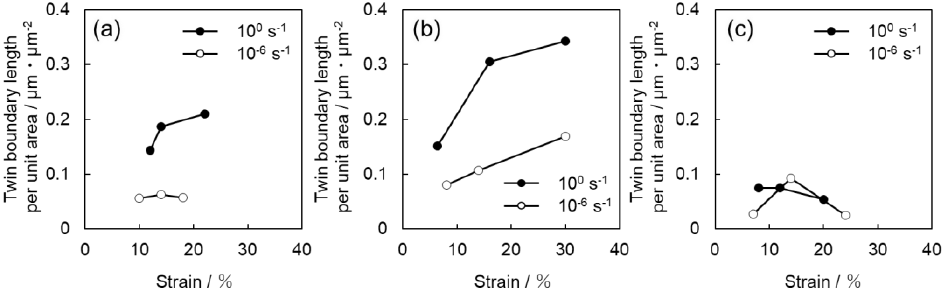
Figure 8. Strain dependence of the twin boundary length per unit area for ( a ) Ti-210, ( b ) Ti-30, and ( c ) Ti-5.